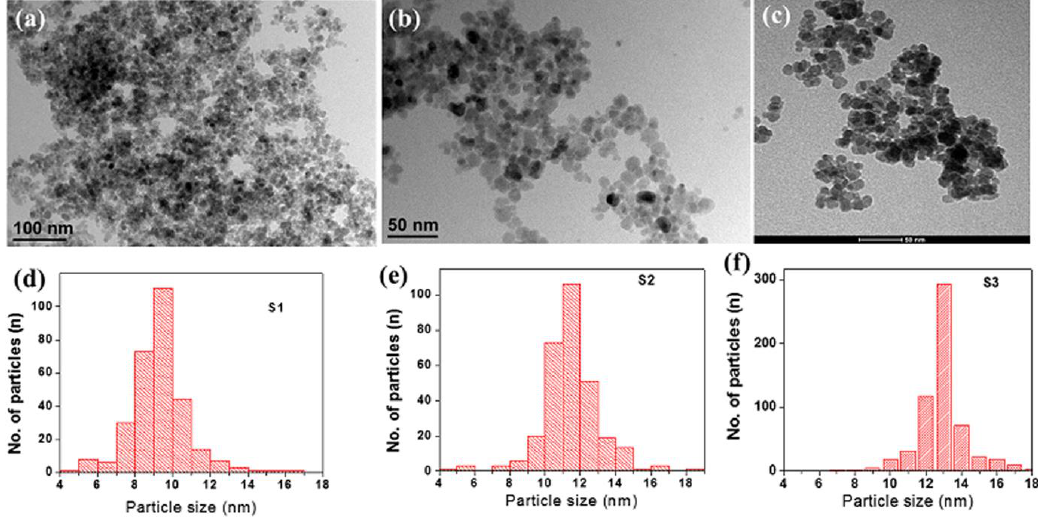
Figure 2. The transmission electron microscopy (TEM) images of samples ( a ) S1; ( b ) S2; and ( c ) S3. The particle size histograms of the samples ( d ) S1; ( e ) S2; and ( f ) S3.